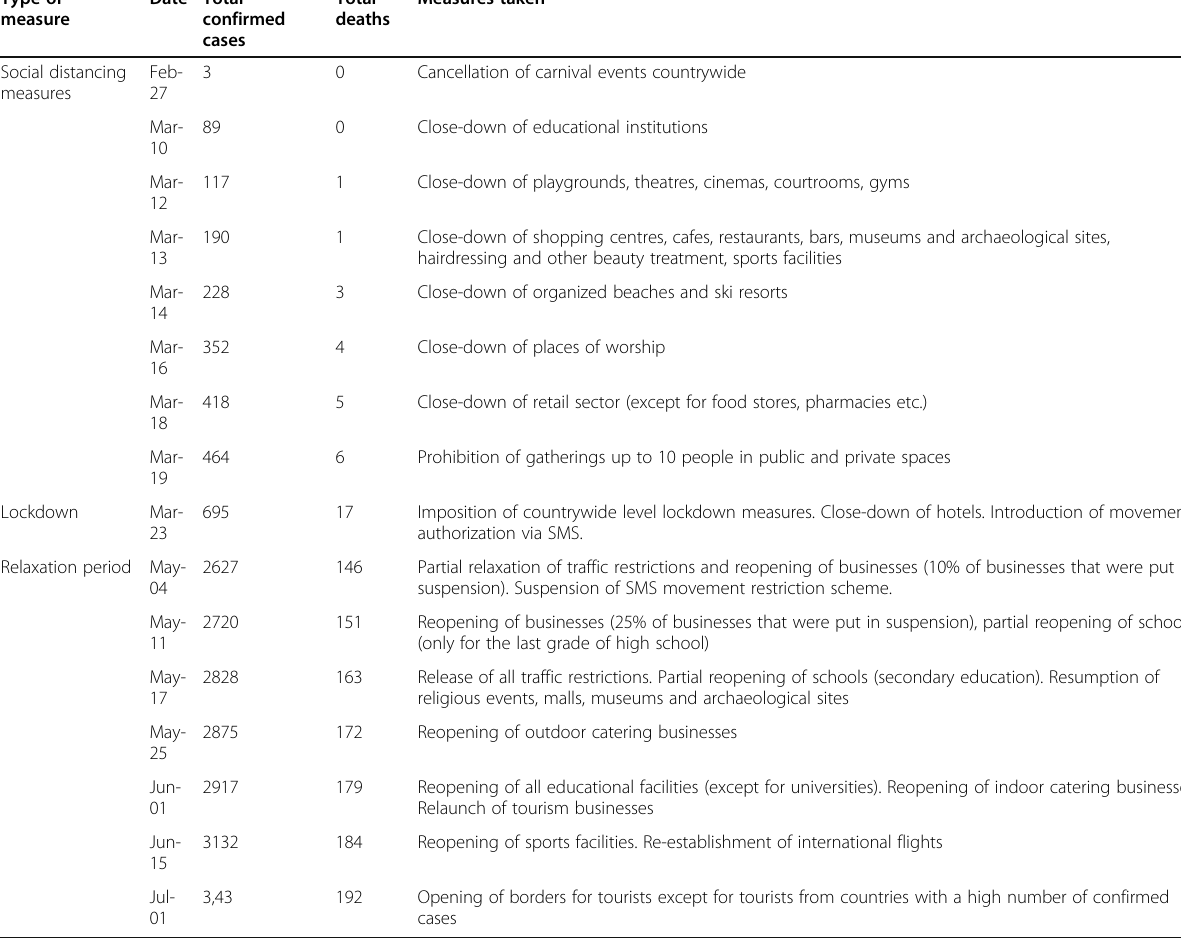
Table 1 Timeline of measures adopted by the Greek government to control the first wave of COVID-19 pandemic Type of